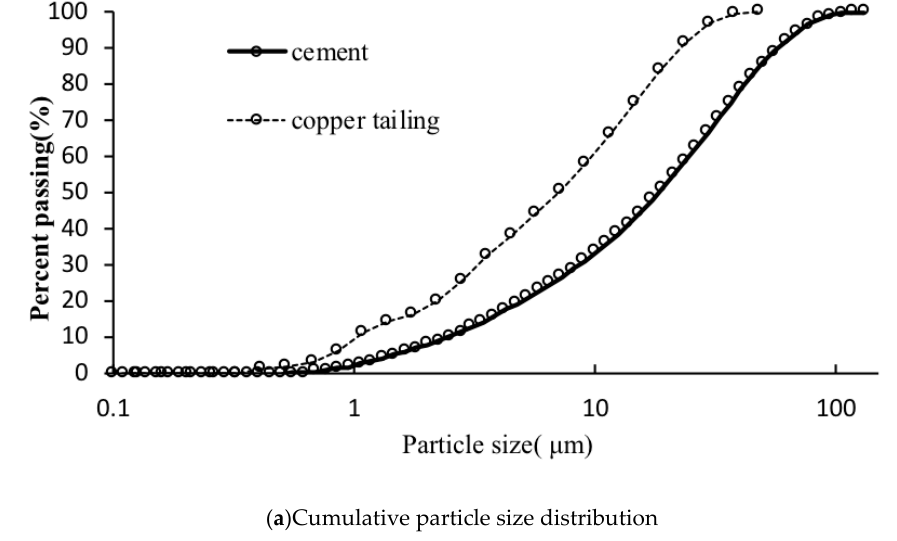
Figure 2. SEM (scanning electron microscope) and the XRD (X-ray diffraction) of copper tailings: ( a ) SEM micro-graphs of copper tailings; ( b ) XRD pattern of copper tailings.